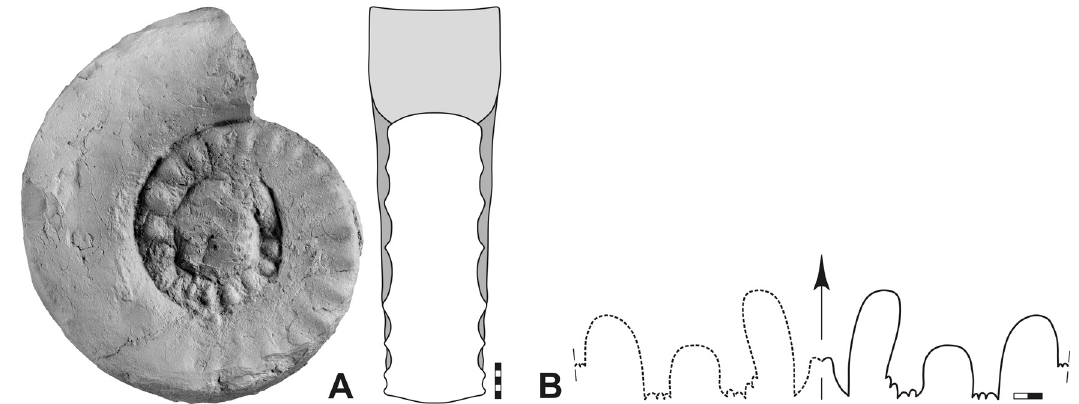
Fig. 47. Alibashites mojsisovicsi (Stoyanow, 1910) A . Lateral and dorsal view, specimen MB.C.29969, section C, -0.75 m. B . Suture line, specimen MB.C.29969, at 12.6 mm wh. Abbreviation: see Material and methods. Scale bar units = 1